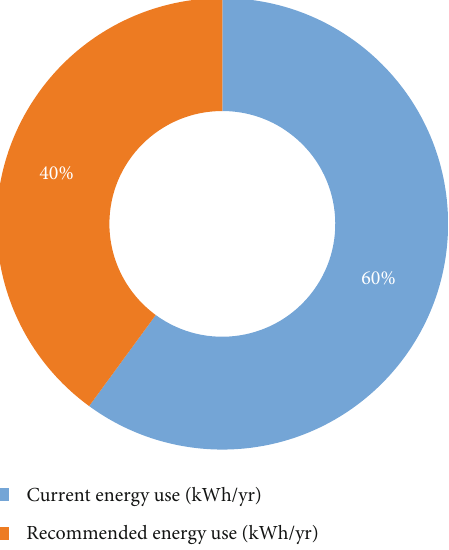
Figure 3: Recommended versus current energy use.